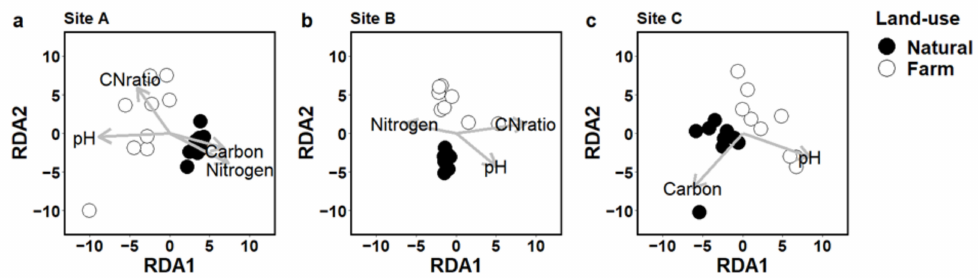
Figure 5. Effects of environmental factors on soil prokaryotic community structures: ( a – c ) RDA plots of prokaryotes in each site at OTU level. The arrows illustrate significant correlations ( p < 0.05) between the prokaryotic communities and the environmental factors by 999 times permutation